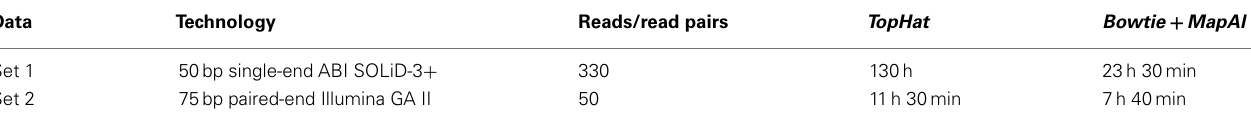
Table 4 | Comparison of pipeline execution